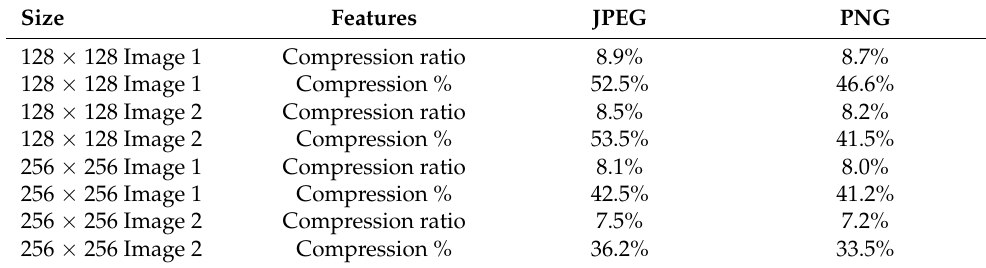
Table 2. JPEG and PNG format comparisons.